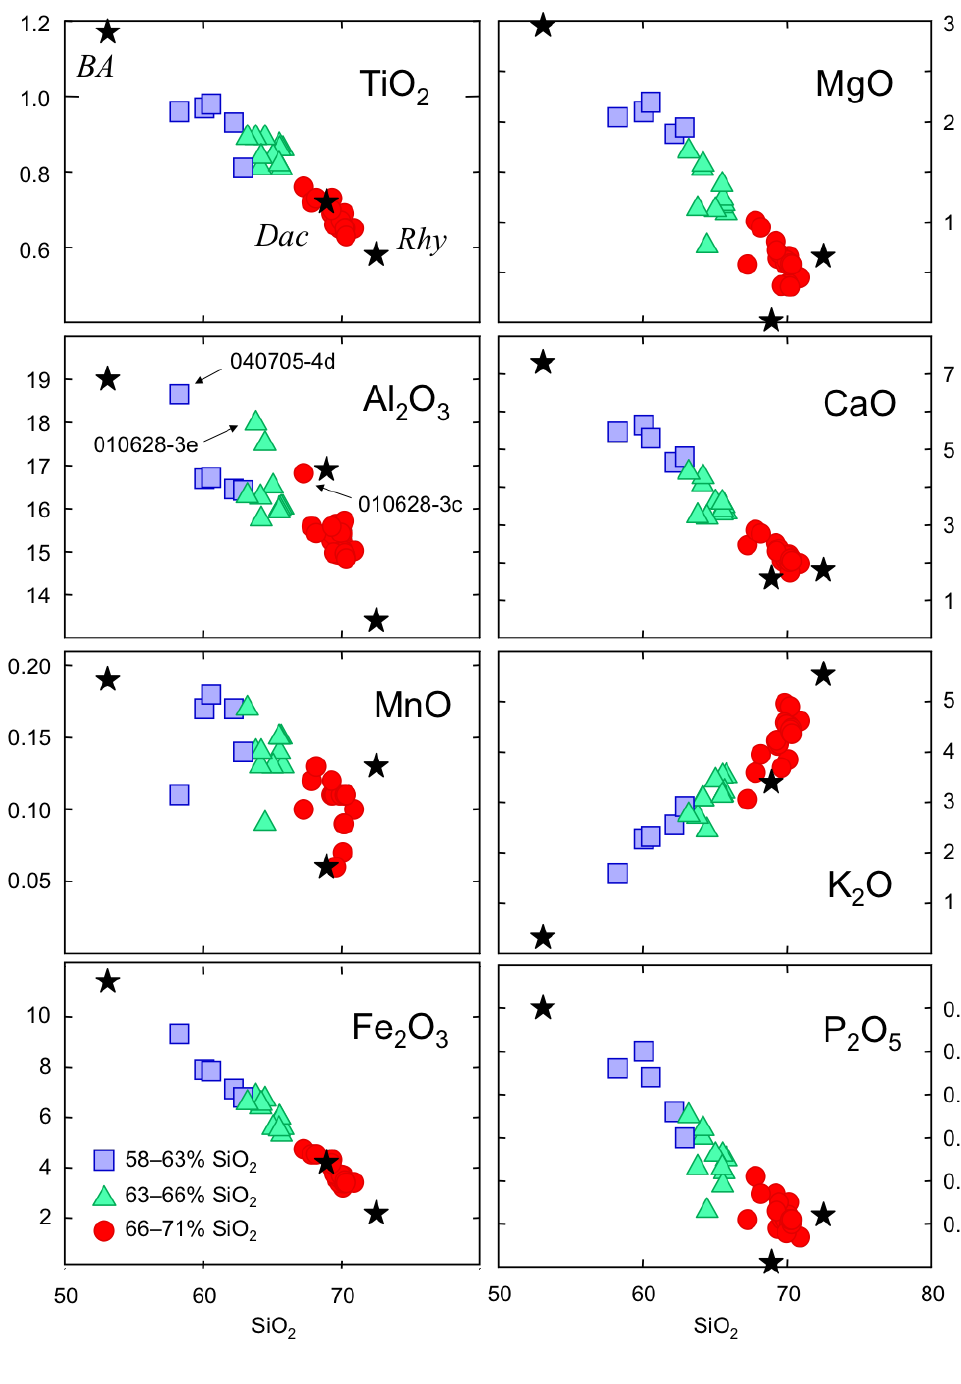
Figure 3. Major element oxides (wt %) plotted against SiO Black stars on chemical variation diagrams show three end member mixing compositions predicted by polytopic vector analysis (PVA) and are explained in the text. Rhy, rhyolite; BA, balsaltic andesite; Dac,